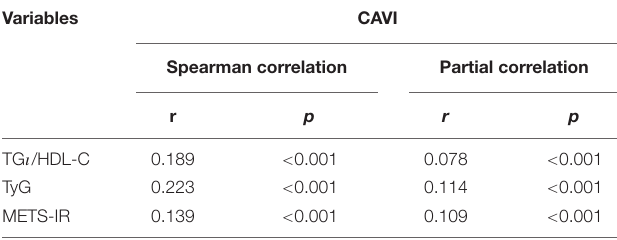
TABLE 2 | Spearman and partial correlation between non-insulin-based IR indices and CAVI. Variables CAVI Spearman correlation Partial